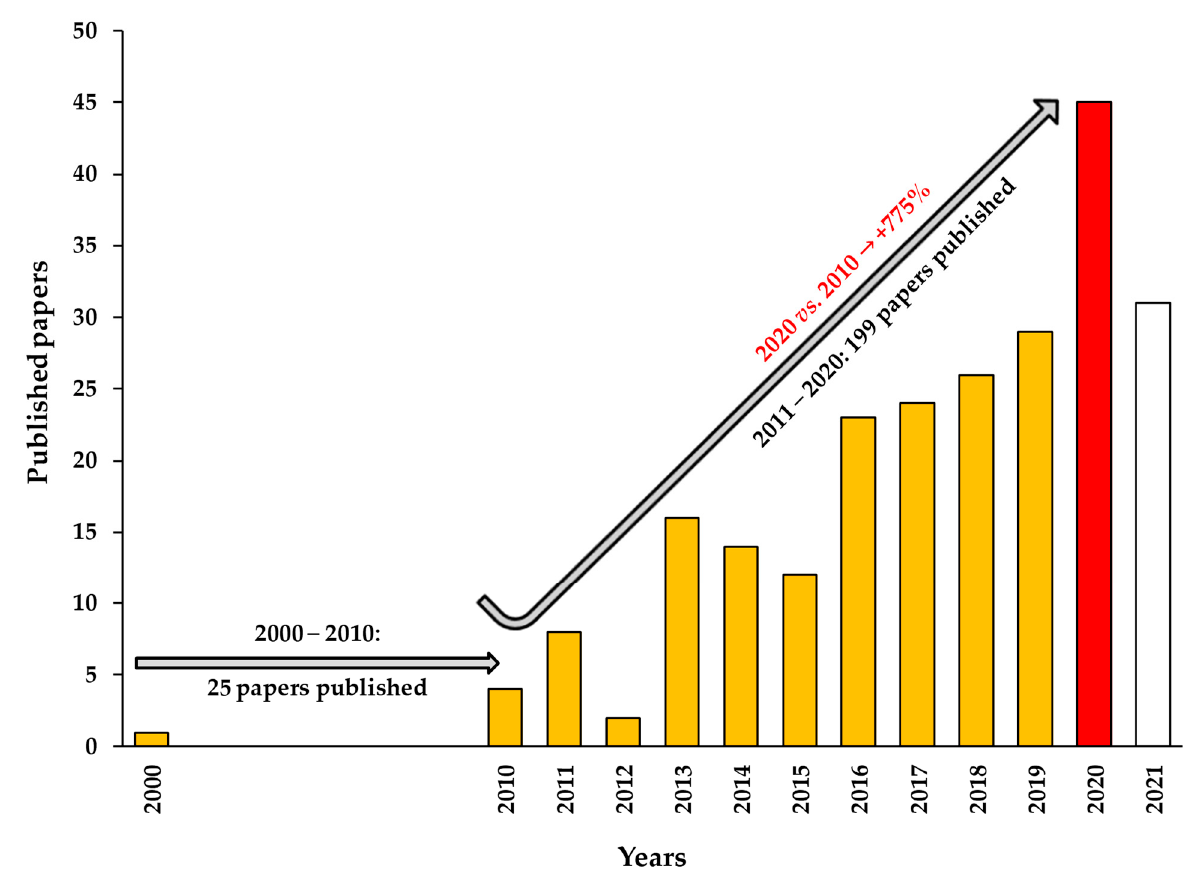
Figure 2. Number of published papers from January 2000 to 2021 in which the words “carnosine and nanoparticles“ were used in Science Direct (last update 1 May 2021). The production of papers from 2000 to 2010 is discontinued (one in 2000, two in 2004, four in 2005, four in 2007, three in 2008, and nine in 2009). The bar representing 2020, currently the most productive year, is highlighted in red. As clearly depicted, during the last decade (2011–2020) the number of publications has increased significantly compared to the previous ten years (2000–2010), 25 vs. 199 published papers (almost 8 times more). The current number of published papers in 2021, still in progress and indicated with a white bar, suggests that this year could represent the most productive of the last two decades. Table 1. List of drug delivery strategies for